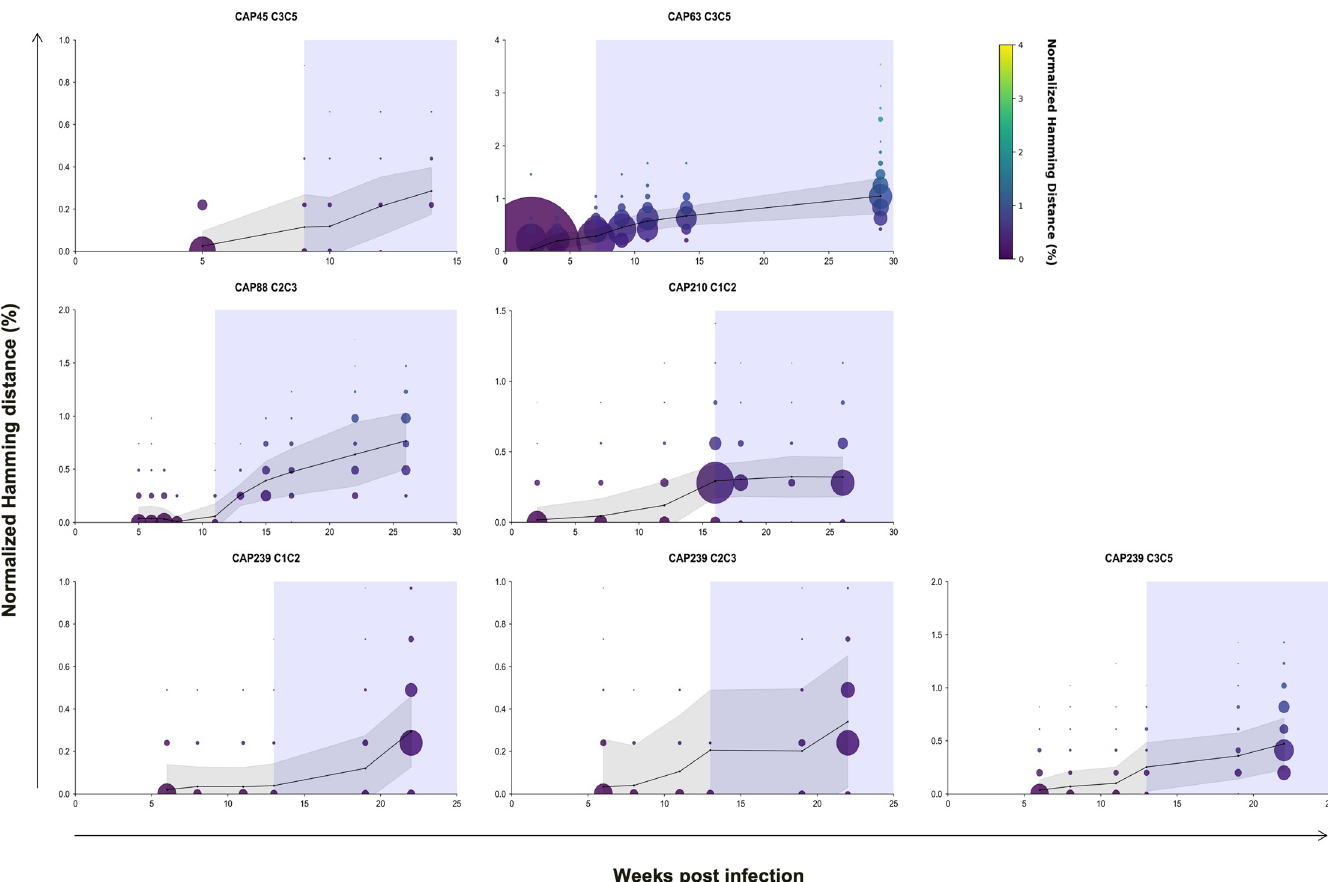
Fig 6. Divergence from T/F sequences in regions targeted by the initial autologous nAb responses in five CAPRISA 002 participants. A total of 51–12842 consensus sequences were generated per time point (an average of 1493 consensus sequences per time point) using Illumina deep sequencing platform and the primer ID method. Average hamming distances, normalised to the nucleotide length of each amplicon, were calculated for sequences generated at each time-point (black line). The bubble size indicates the size of the viral population, scaled by viral load. The shaded region indicates the time from which the initial autologous antibody response was first detected (IC 50 ). Hamming distances were adjusted that so deletions were calculated as one